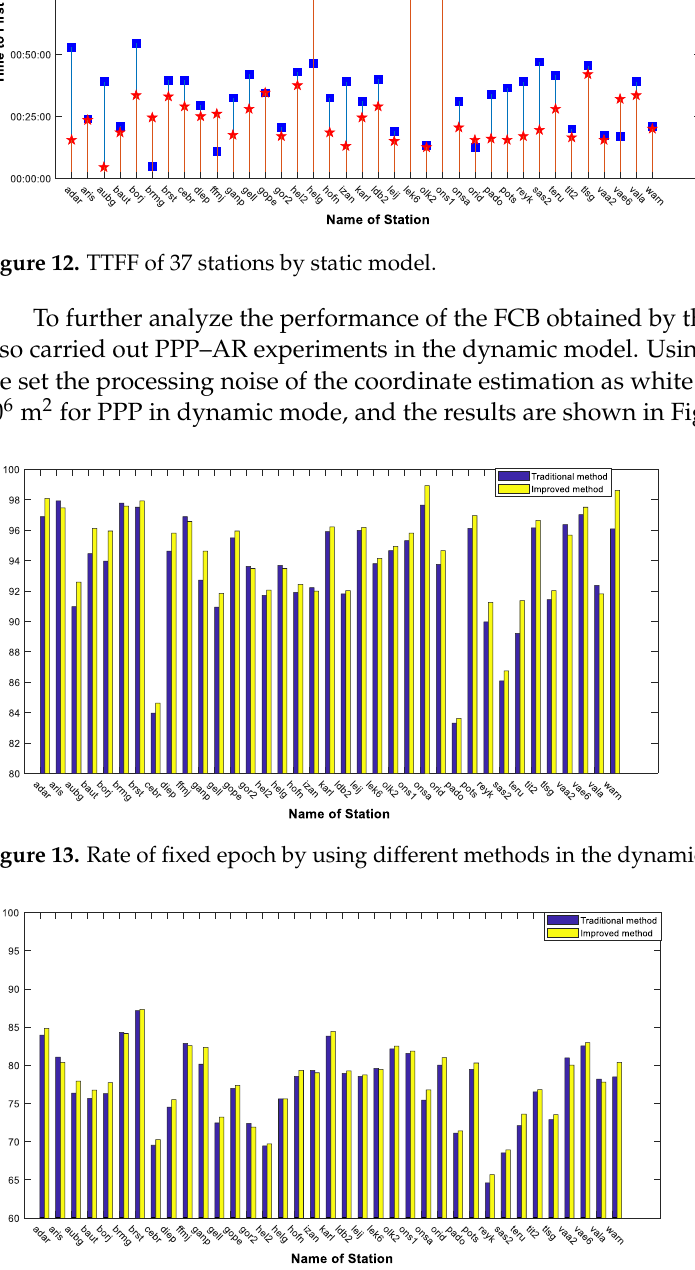
13 of 17 Figure 10. Rate of fixed epochs by using different bias products (2021, day 185). Figure 11. Rate of fixed NL ambiguities by using different bias products (2021, day 185). From Figure 10, the static  of most stations is more than 90%, and the mean static  that uses the traditional and proposed methods are 94.50% and 94.96%, respectively. The static 